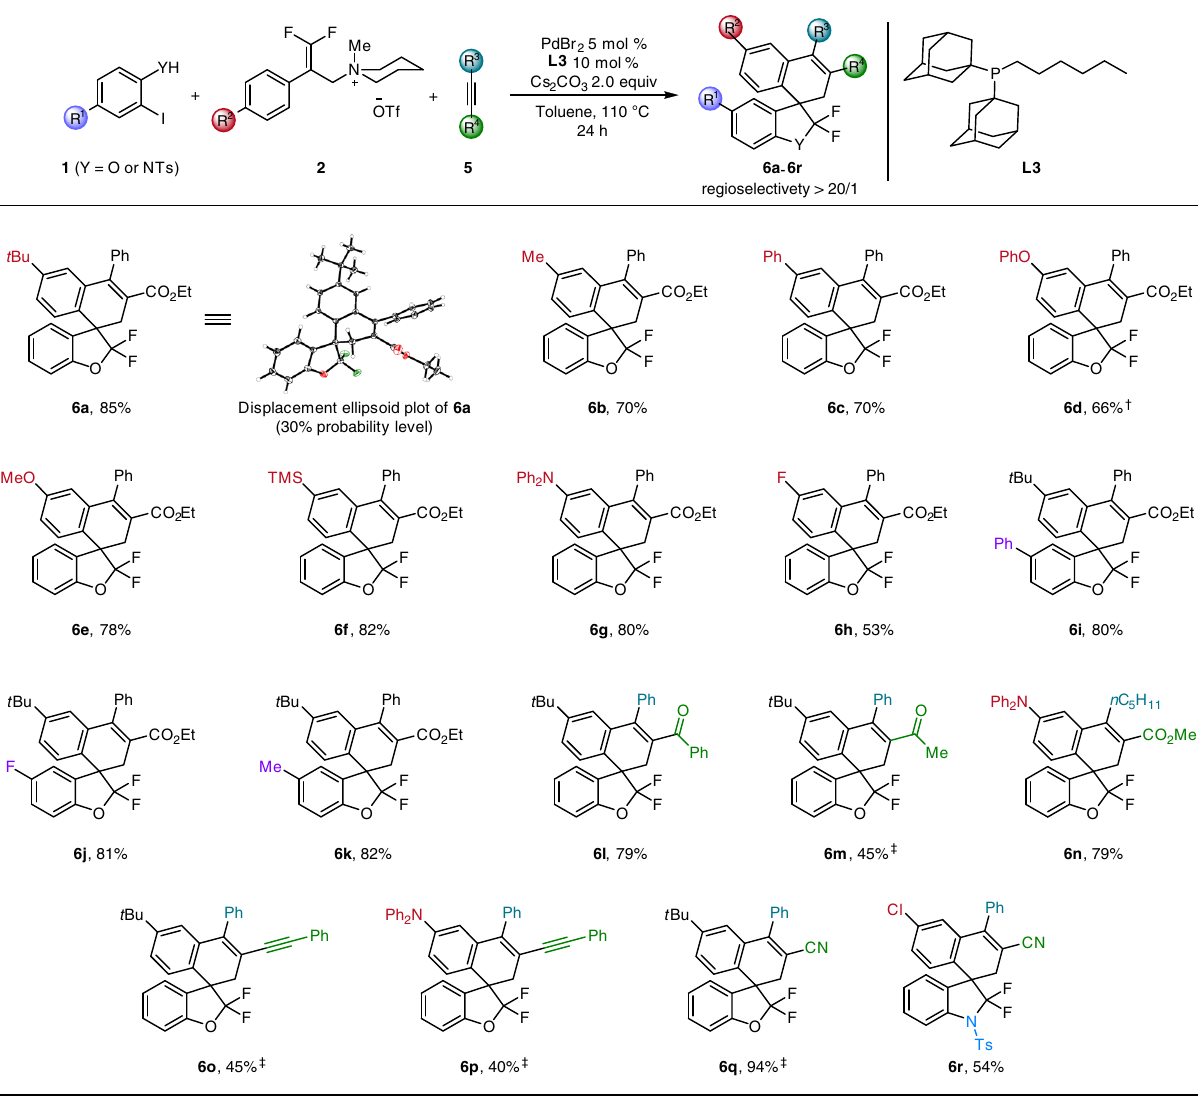
Fig. 4 Palladium-catalyzed three-component cascade spriocyclizations. Standard reaction conditions: 1 (0.2 mmol), 2 (0.2 mmol), 5 (0.4 mmol), Cs 2 CO 3 (0.4 mmol), PdBr 2 (0.01 mmol), L3 (0.02 mmol), toluene (1.0 mL), the reaction mixture was stirred at 110 °C under argon atmosphere for 24 h, isolated yield, the regioselectivity of 6 was determined by crude 19 F NMR analyses. † 2 mol% PdBr 2 and 4 mol% L3 were used. ‡ 10 mol% PdBr 2 and 20 mol% L3 were